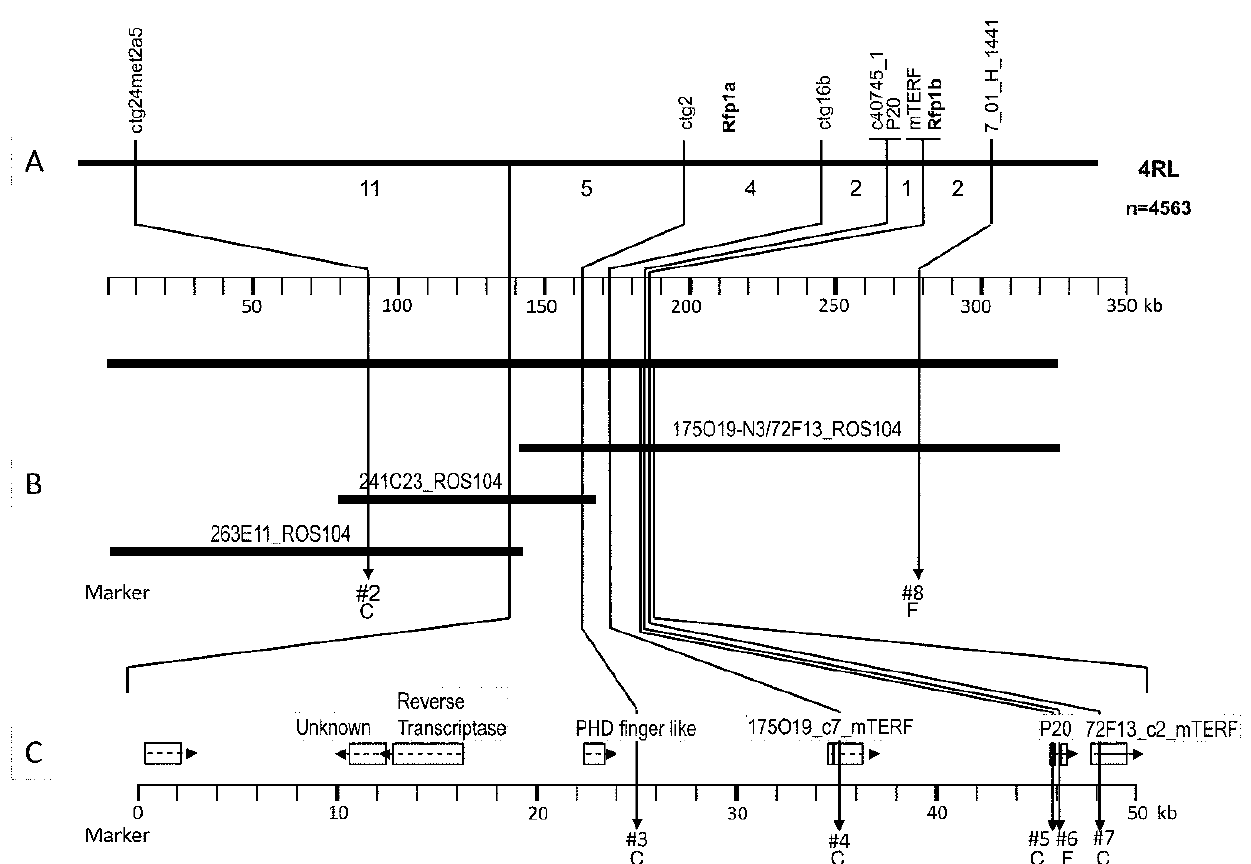
Figure 5. Organization of the Rfp1 locus on chromosome 4RL [47]. ( A ). number of recombinations between named markers; ( B ). overlapping BAC clones; ( C ). putative candidate genes.